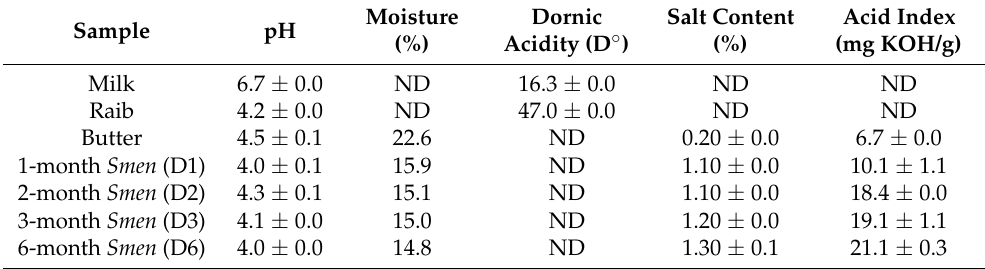
Table 3. Physicochemical properties of samples collected during Smen manufacture